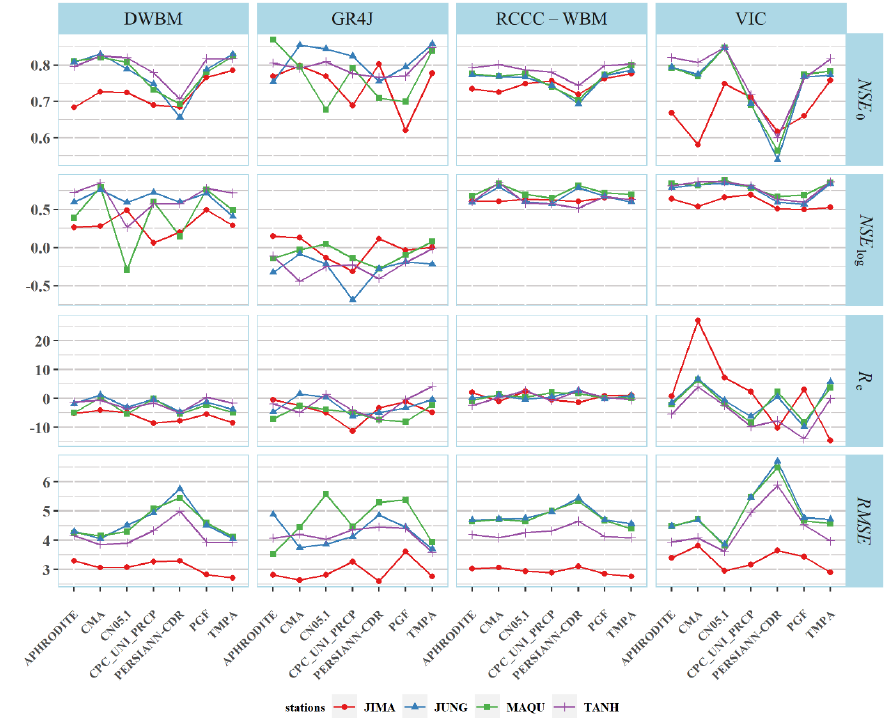
Figure 7. Results of hydrological modeling performance evaluation indices ( NSE 0 , NSE log , R e , and RMSE ) in the calibration period (1998–2008) at 4 hydrometric stations (JIMA, MAQU, JUNG, and TANH), using 4 hydrological models (DWBM, GR4J, RCCC-WBM, and VIC). Remote Sens. 2020 , 12 , x FOR PEER REVIEW